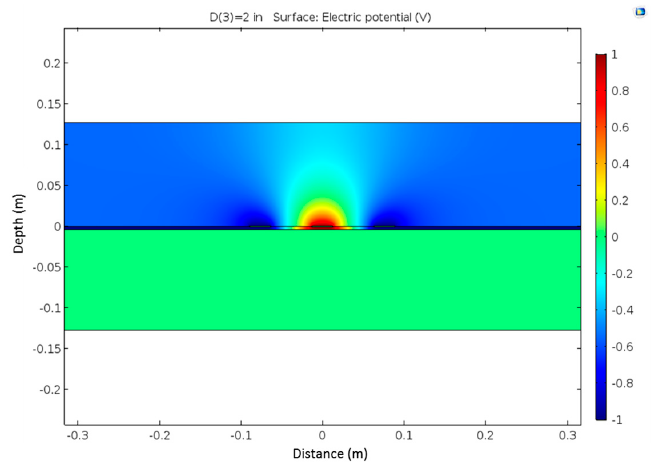
Figure 10. Electric potential distribution.